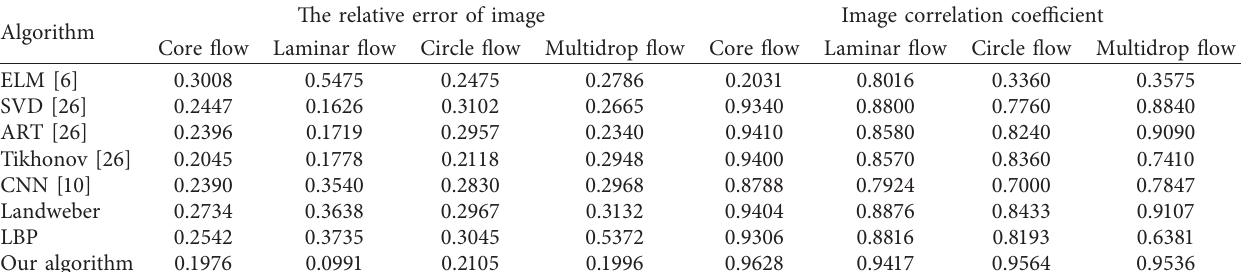
Table 8: Comparison with previous research results.